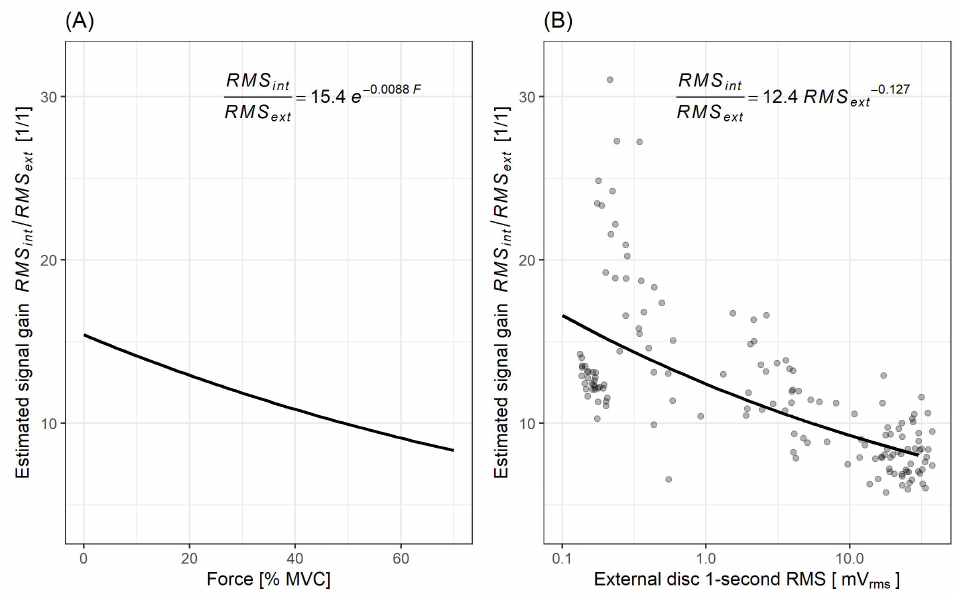
Figure 7. Estimated signal gain ( RMS int / RMS ext ) as a function of: ( A ) force ( F ), represented as % MVC, ( B ) RMS ext (data-points recalculated based on experimental data). In Figure 8 the relationship between EMG and MMG recorded from both external and internal piezoelectric discs during step isometric contractions is shown.